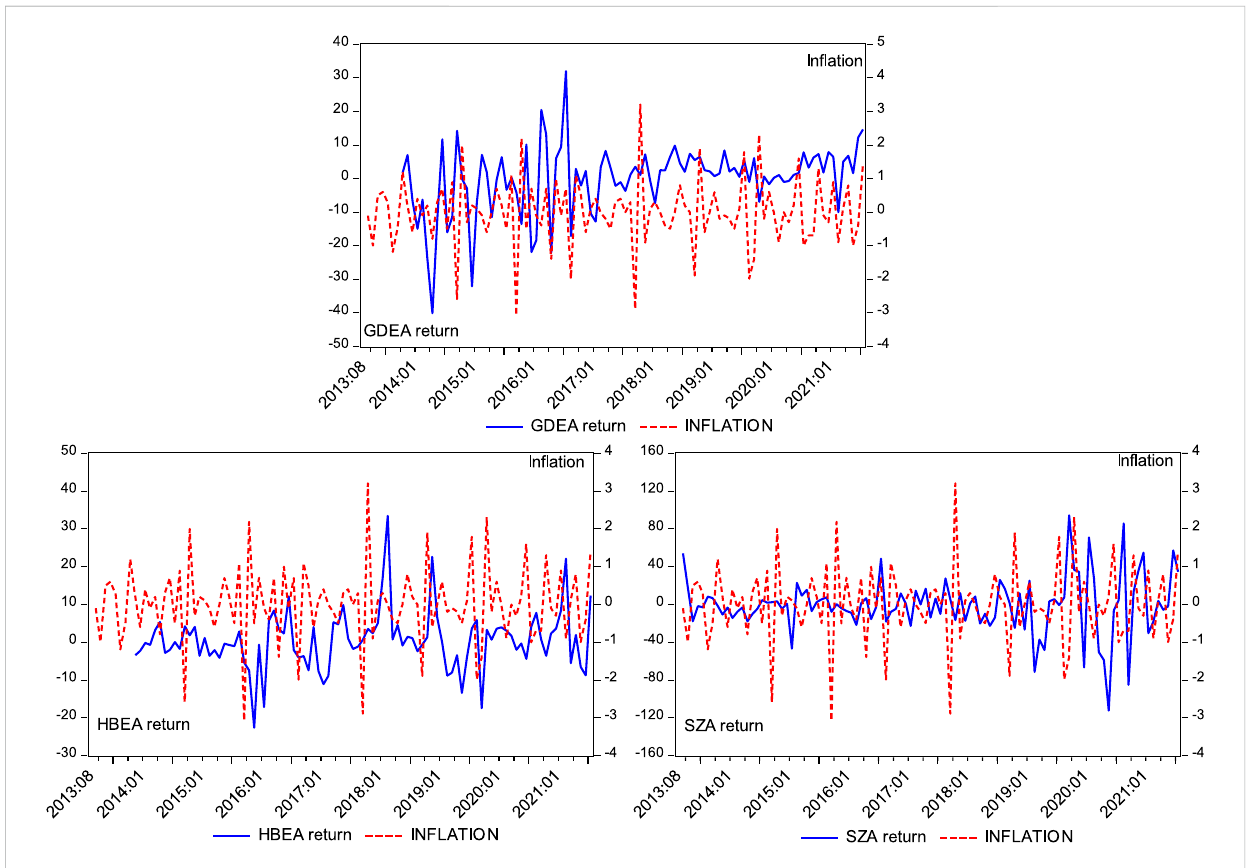
In fl ation (%) and carbon returns (%) for the Guangdong, Hubei, and Shenzhen pilots from 2013 to